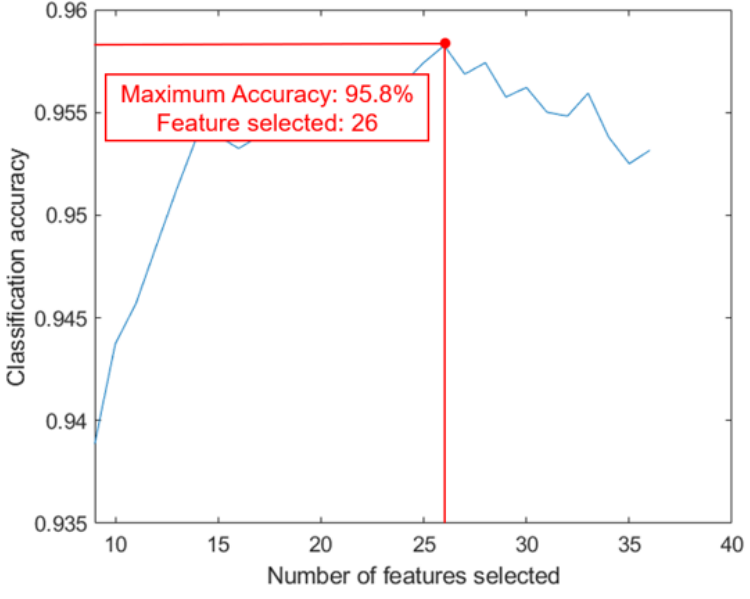
Figure 13. Classification accuracy evolution with SFS applied to SVM cubic